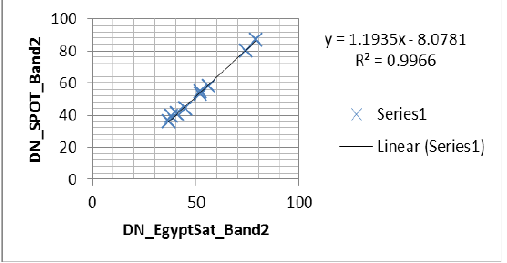
Figure 3. Scatter plot of SPOT-4 and Egyptsat-1 DN’s for the second band